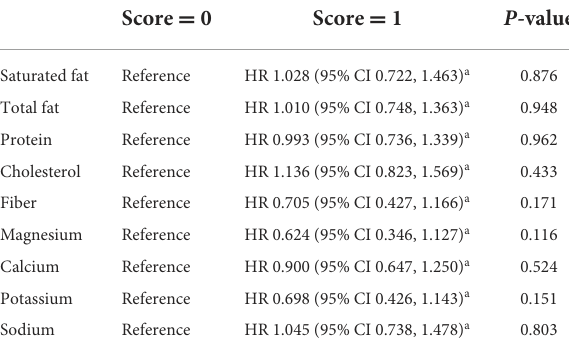
TABLE 4 Associations of DASH score components with all-cause